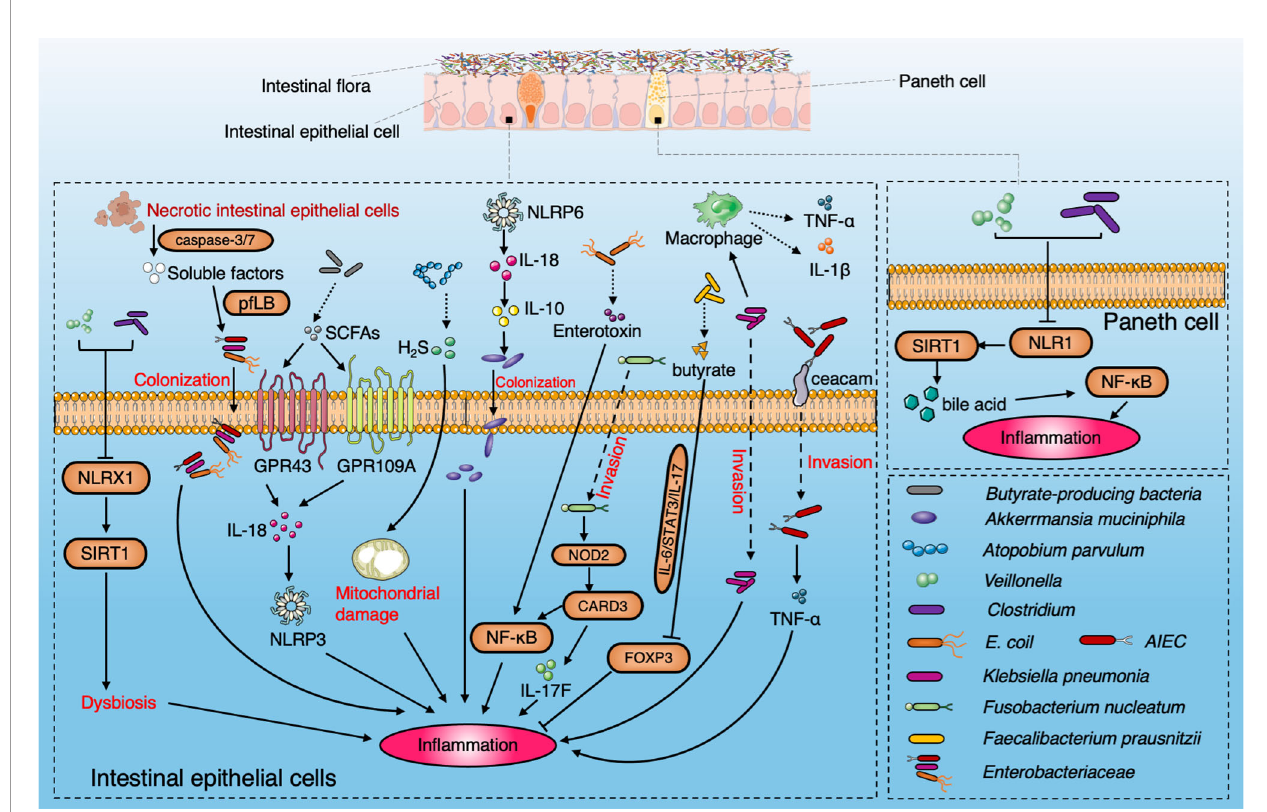
FIGURE 2 | Diagram summarizing the pathogenic interaction between the gut microbiome and intestinal epithelial barrier in IBD. NLRX1 boosts the dysbiosis to induce the ileac in fl ammation via SIRT1 signaling pathway with enrichment of Veillonella and Clostridium . SCFAs produced by microbiota induce the activation of NLRP3 through GPR43 and GPR109A and protect colitis through IL-18. A. parvulum produce H2S to induce ileac in fl ammation by mitochondrial damage. NLRP6 is a key regulator to facilitate the colonization of A. muciniphila via IL-18 and IL-10 to promote IBD onset. AIEC penetrate the mucus layer and adhere to intestinal epithelial cells through FimH and ceacam6. Enterotoxin secreted by E. coli induce IBD by the NF- k B pathway. SIRT1 participates in the in fl ammation by stimulating Paneth cell to re fl ect the bile acids metabolism via the NF- k B signaling pathway. Klebsiella pneumoniae invades intestinal epithelial cells and promotes the secretion of IL-1 b and TNF by interacting with macrophages. Fusobacterium nucleatum upregulates CARD3 via NOD2 in colonic epithelial cells to activate the IL-17F/NF- k B signaling pathway. Faecalibacterium prausnitzii produce butyrate to inhibit the IL-6/STAT3/IL-17 pathway to activate Foxp3.The soluble factors released by apoptotic intestinal epithelial cells through caspase3/7 facilitate the colonization of Enterobacteriaceae by driving the pyruvate formate-lyase-encoding p fl B